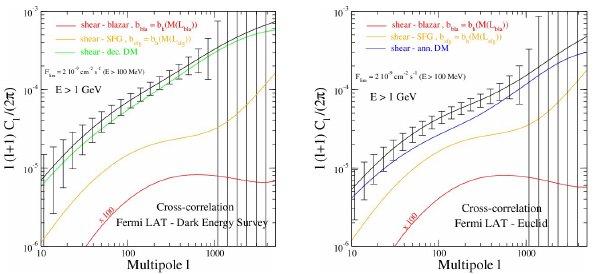
Left : Cross-correlation between cosmic shear and γ -ray emission, for the different classes of γ - ray emitters described in the text (with a γ -ray thresh- old expected for Fermi-LAT after 5 years of exposure). Each contribution is normalized by multiplying Eq. (2) by (cid:104) I j (cid:105) / (cid:104) I EGB (cid:105) to make them additive. DES is taken as the reference galaxy survey. Error bars are estimated for the total signal (in black). Right: Same as in the left panel but for annihilating DM, with Euclid as the ref- erence galaxy survey. This figure is taken from Camera et al.